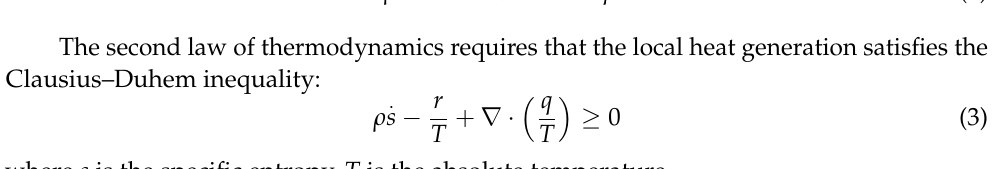
Figure 3. A schematic ∆ T AS vs. σ curve to determine the fatigue endurance limit.